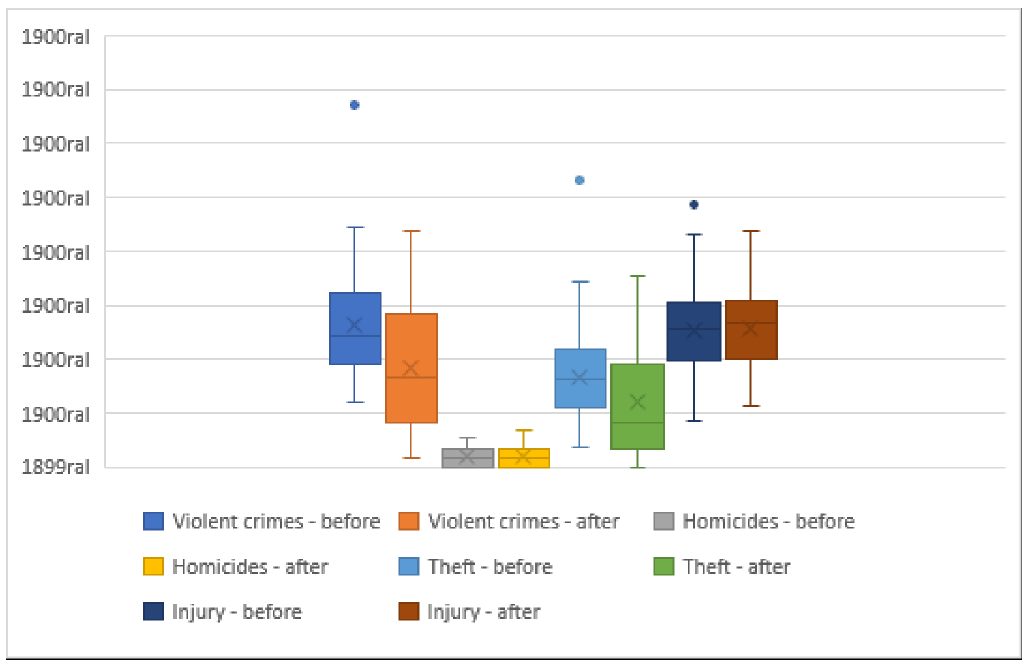
Boxplot for all the